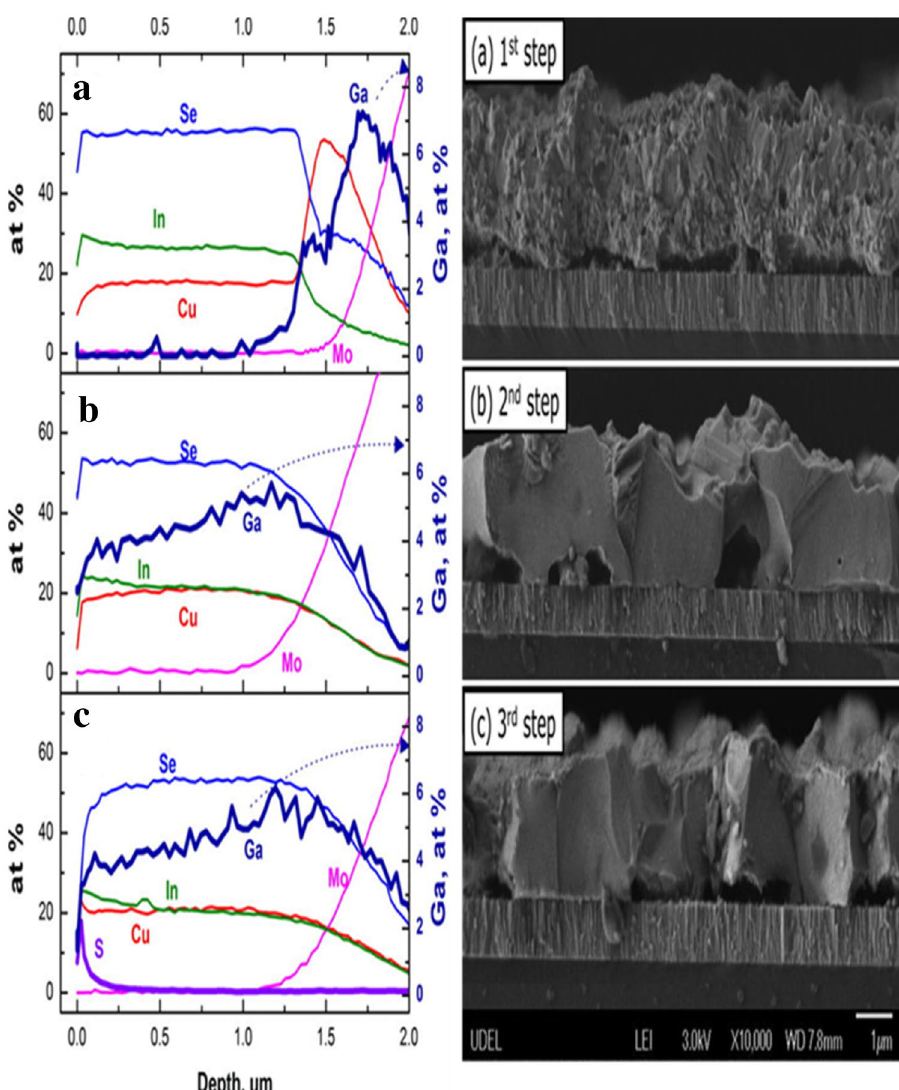
Fig. 9 Compositional depth profiles determined by AES of the reacted CIGSe (or CIGSeS) films after a H 2 Se (400 °C for 60 min), b Ar (550 °C for 20 min) and c H 2 S (550 °C for 10 min) and corresponding cross-sectional SEM images of reacted CIGSe or CIGSeS films after a 1st step, b 2nd step, and c 3rd step. Reprinted from Kim et al. [102] with the permission of AIP